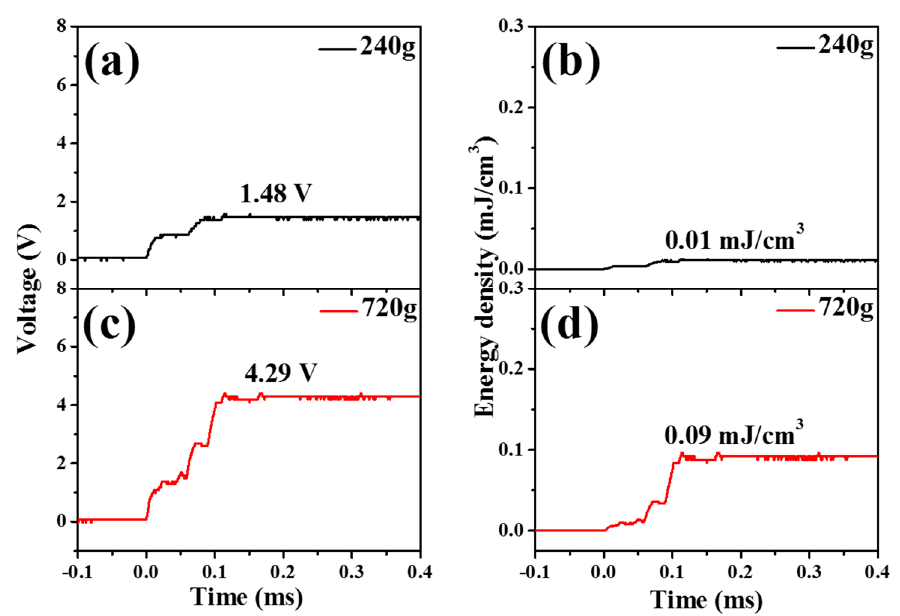
Figure 8. The generated output voltage and energy from piezoelectric energy harvesters without a spring structure. The energy was stored in a 10 μ F capacitor. The generated output voltage of a 240 g weight ( a ), generated energy of a 240 g weight ( b ), generated output voltage of a 240 g weight ( c ), generated energy of a 720 g weight ( d ).